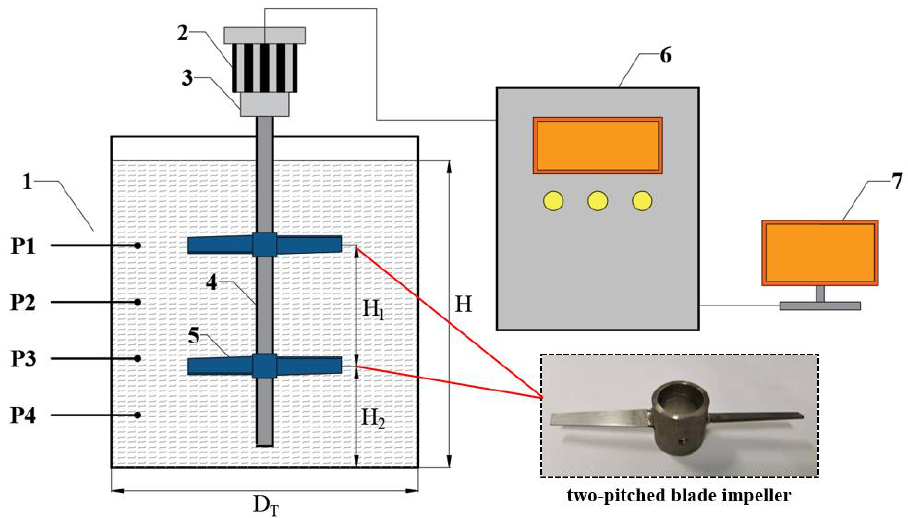
Figure 1. Schematic diagram of the experimental setup: 1. Optical fiber probe (P1–P4); 2. Motor; 3. Torque sensor; 4. Mixing shaft; 5. Impeller; 6. Control cabinet; 7.